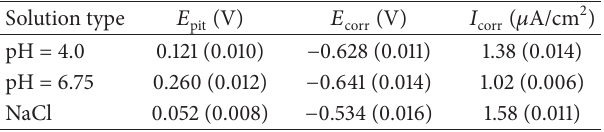
Table 2: The pitting potential ( 𝐸 respect to SCE, and corrosion current density ( 𝐼 potentiodynamic polarization